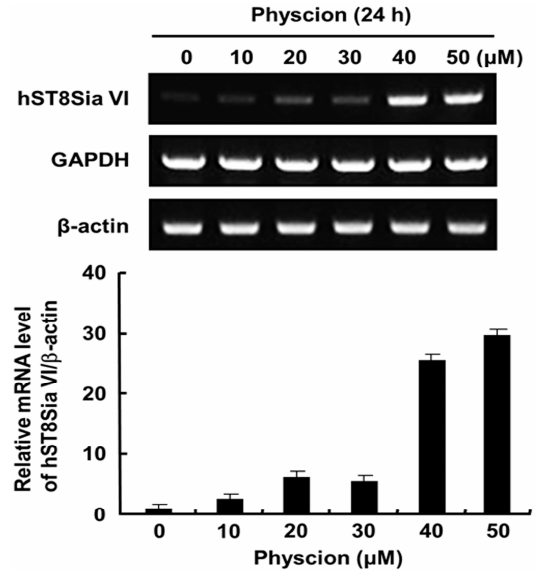
Figure 2. Effect of physcion on hST8Sia VI mRNA level in SK-N-BE(2)-C cells. After 24 h treatment with various concentration of physcion in the panel up , total RNA from SK-N-BE(2)-C cells was isolated. RT-PCR was used to detect hST8Sia VI mRNA level. In the panel below , the levels of each RT-PCR product were analyzed by densitometry and normalized by β -actin mRNA level as a control. Data reveal the relative values ± SD of three independent experiments.